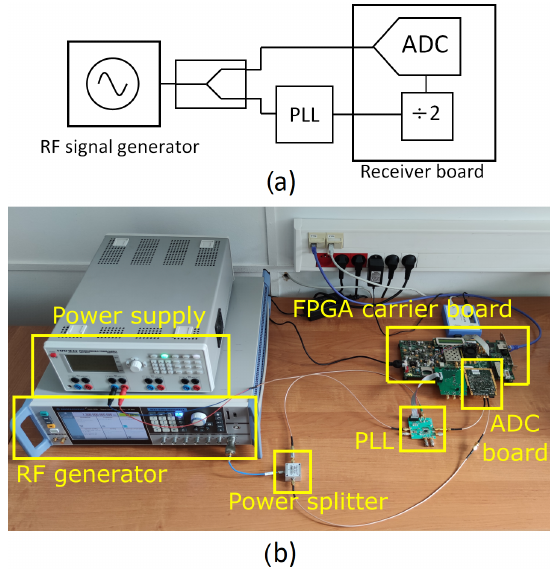
Figure 8. ( a ) Block diagram and ( b ) photo of the measurement set-up for the experimental evaluation of the amplitude and phase stability of the RF